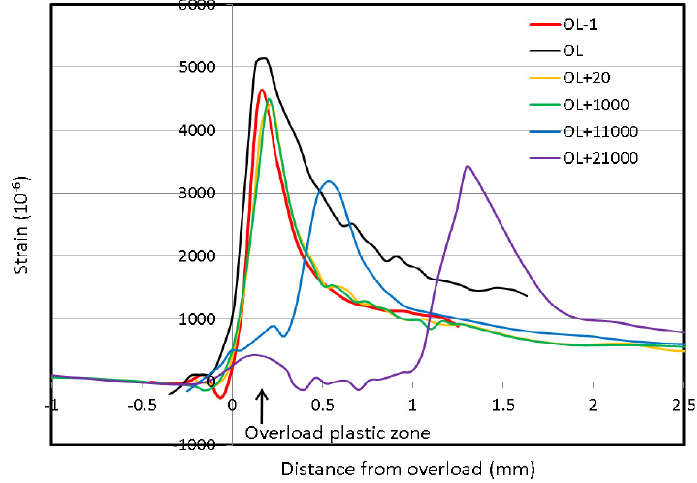
Figure 6: Plots showing the change in elastic strain between K max and K min as a function of number of cycles. The arrow shows the location of the extensive plastic deformation from the overload